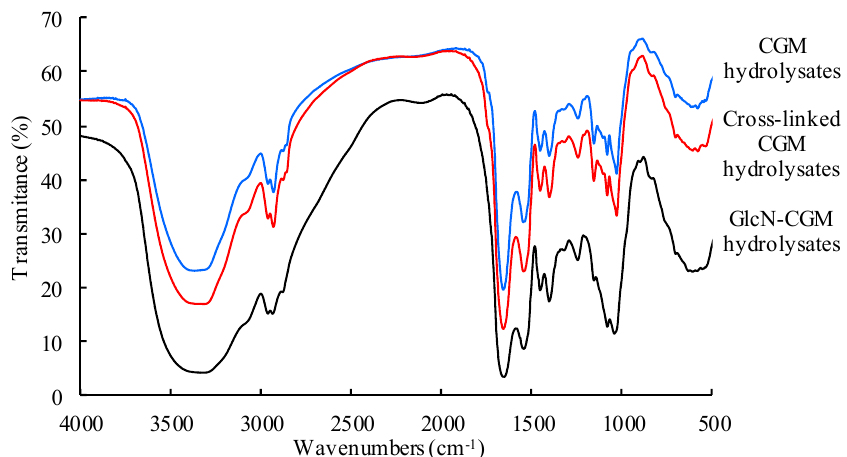
Figure 1. Fourier-transform infrared (FTIR) spectra in KBr pellets of corn gluten meal (CGM) hydrolysates, cross-linked CGM hydrolysates and glucosamine (GlcN)-CGM hydrolysates.